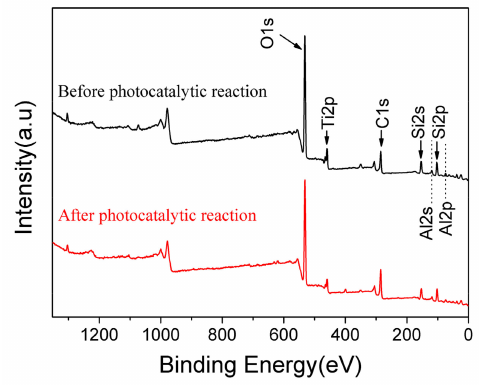
Figure 9. XPS survey spectrum of 10% GO / TiO 2 / Bent sponge before and after photocatalytic reaction.